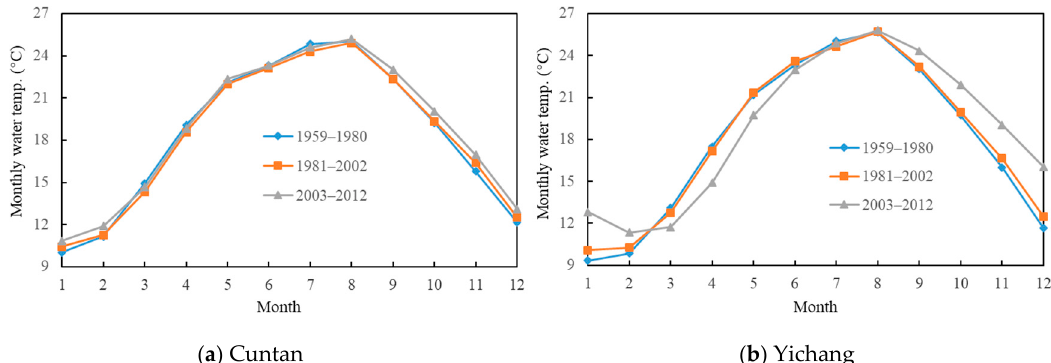
Figure 6. Impact of reservoirs on the monthly distribution of water temperature.